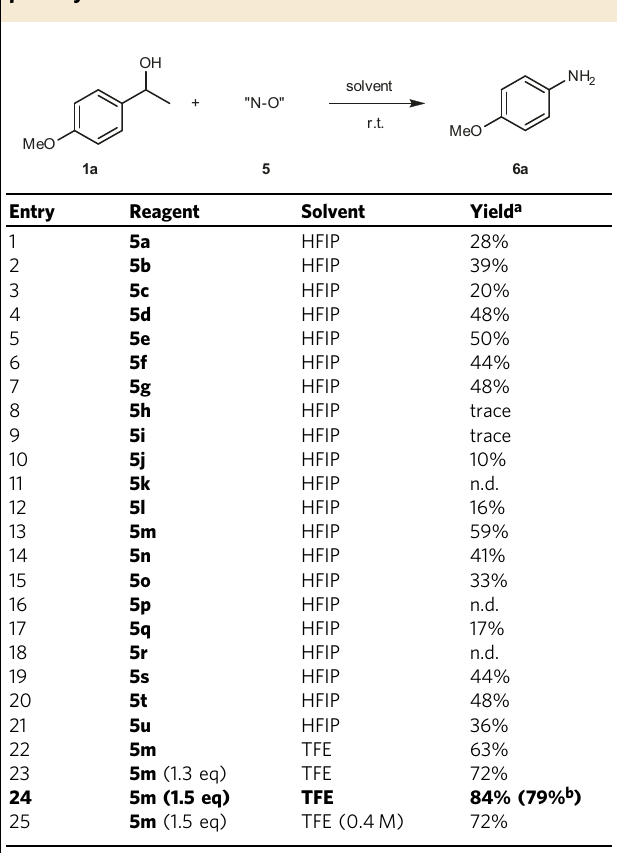
Table 2 Optimization of the C – C amination providing primary anilines.